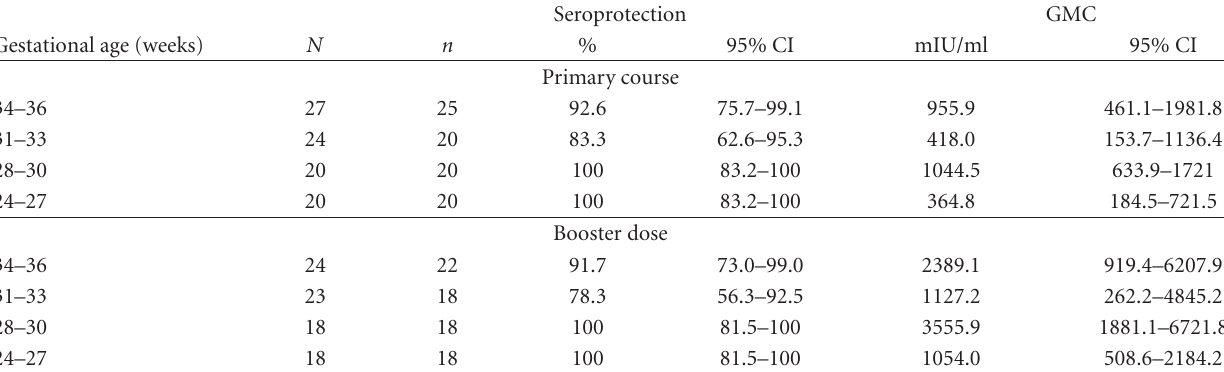
Table 2: Anti-HBs seroprotection rates (SR) and geometric mean concentrations (GMC) by subgroup of preterm infants after primary course and booster dose (ATP cohort for